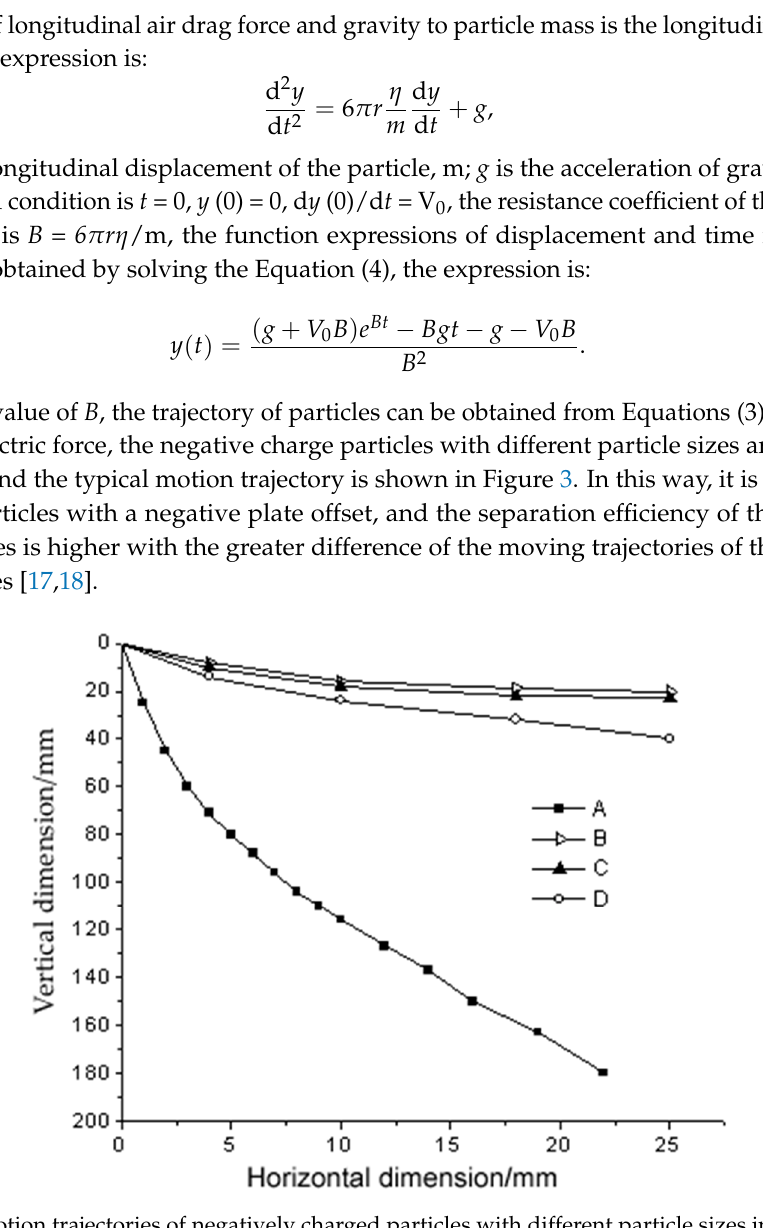
Figure 3. Motion trajectories of negatively charged particles with different particle sizes in an electric field [17,18]. A, B, C and D represent 44 µ m, 106 µ m, 209 µ m, 400 µ m particals